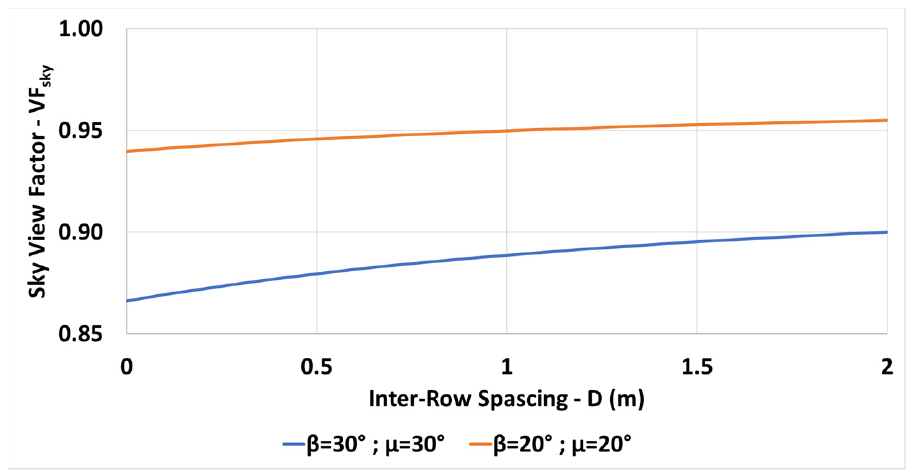
Figure 16. Variation of the sky view factor on triangles on a horizontal plane.